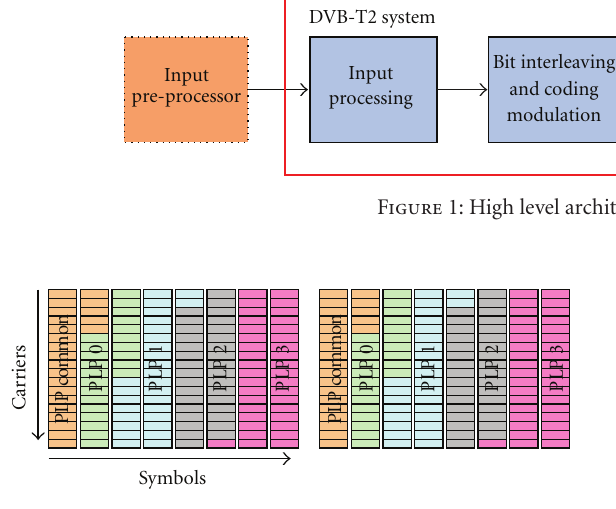
Figure 2: Di ff erent PLP’s occupying di ff erent slices of individual modulation, code rate, and time interleaving.